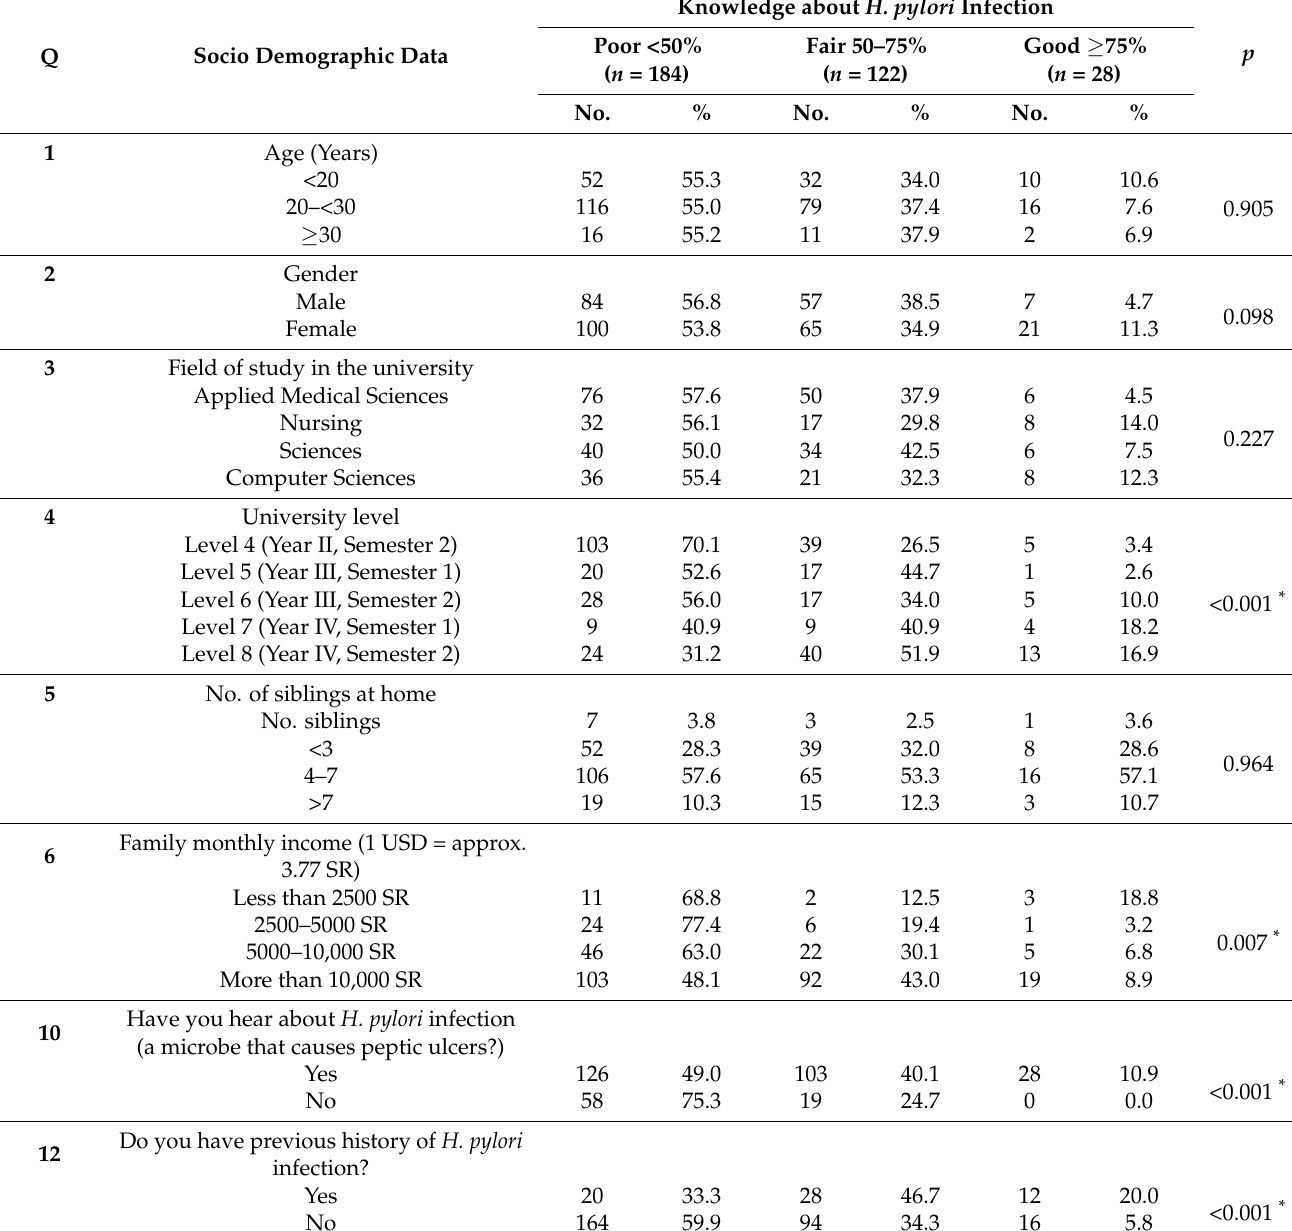
Table 3. Relationship between the socio-demographic characteristics and the knowledge of the respondents about H. pylori infection ( n =